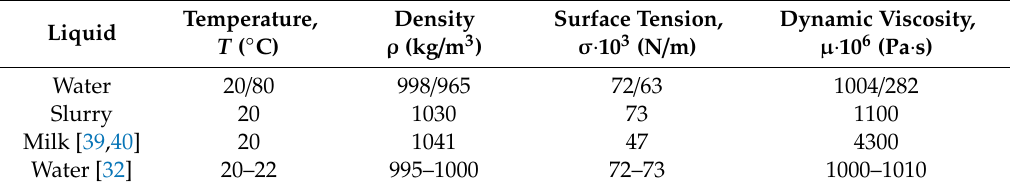
Table 1. Main properties of liquids.